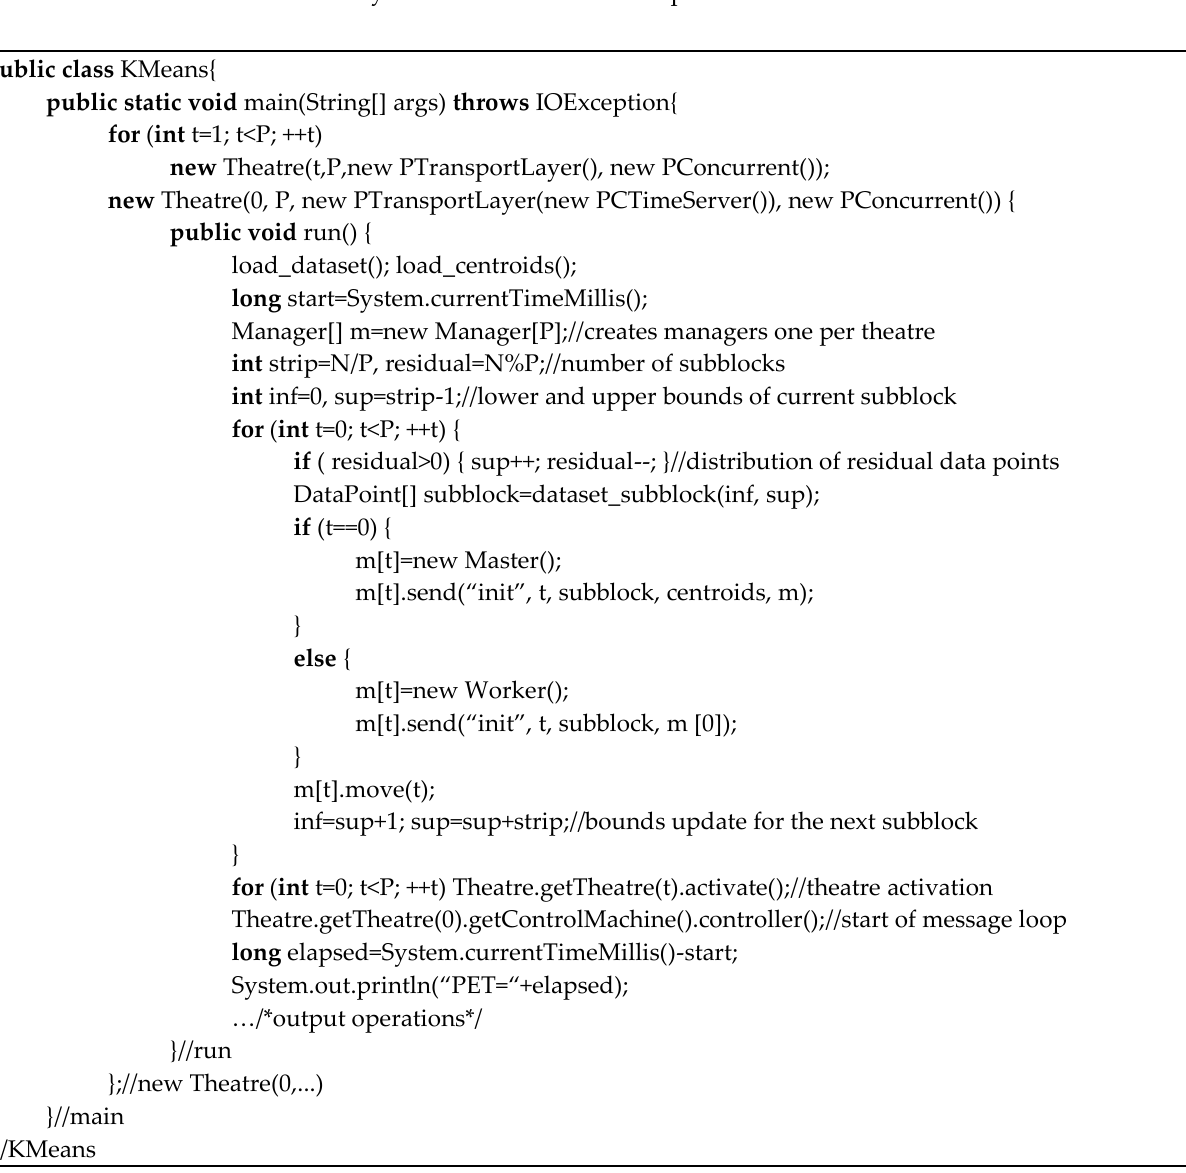
Figure 7. Configuration program for parallel K-Means based on Theatre.